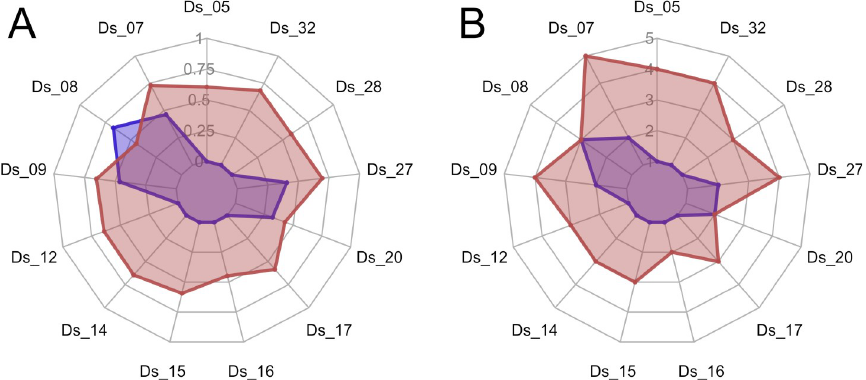
Fig 3. Diversity indices of the Ste Foy and SF-IsoA populations. Radar plot of (A) gene diversity ( H e ) and (B) the number of observed alleles ( N a ) at 13 microsatellite loci for the Ste-Foy (red) and SF-IsoA populations (blue). https://doi.org/10.1371/journal.pone.0247756.g003 population diversity did not influence the variations in our bioassays (relative potency for females SF-IsoA:Ste-Foy = 0.76, t-value = -1.12, p-value = 0.262 and relative potency for males SF-IsoA:Ste-Foy = 1.26, t-value = 1.57, p-value = 0.116).